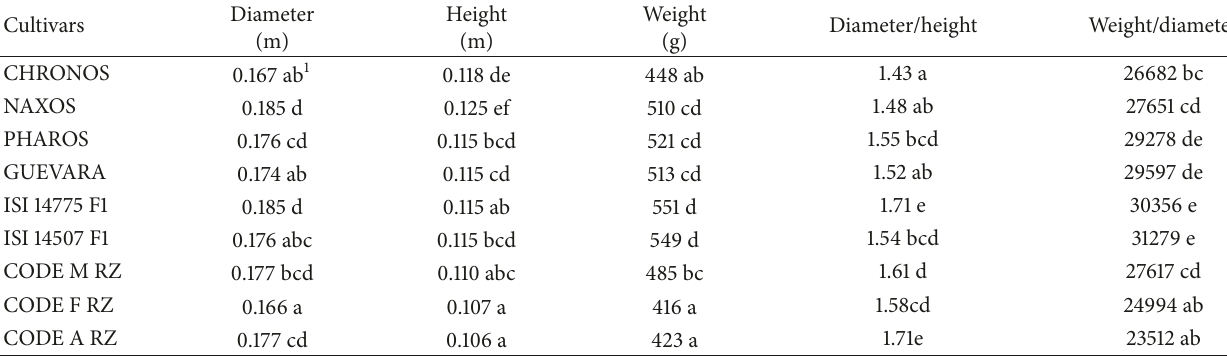
Table 3: Agronomic characteristics of head from nine broccoli cultivars.